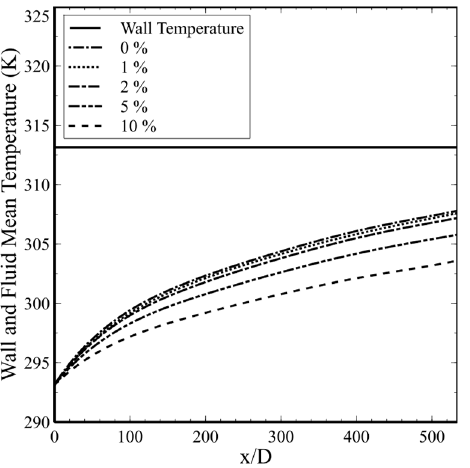
Figure 9. Effect of nanoparticle concentration in tube flow: axial development of wall and T m .